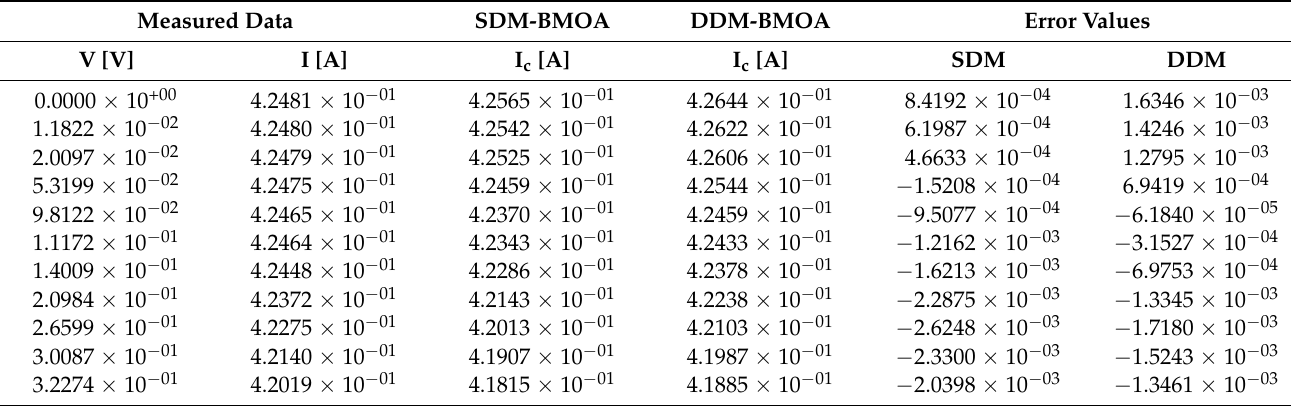
Table 2. (I, V) points of monocrystalline silicon photovoltaic